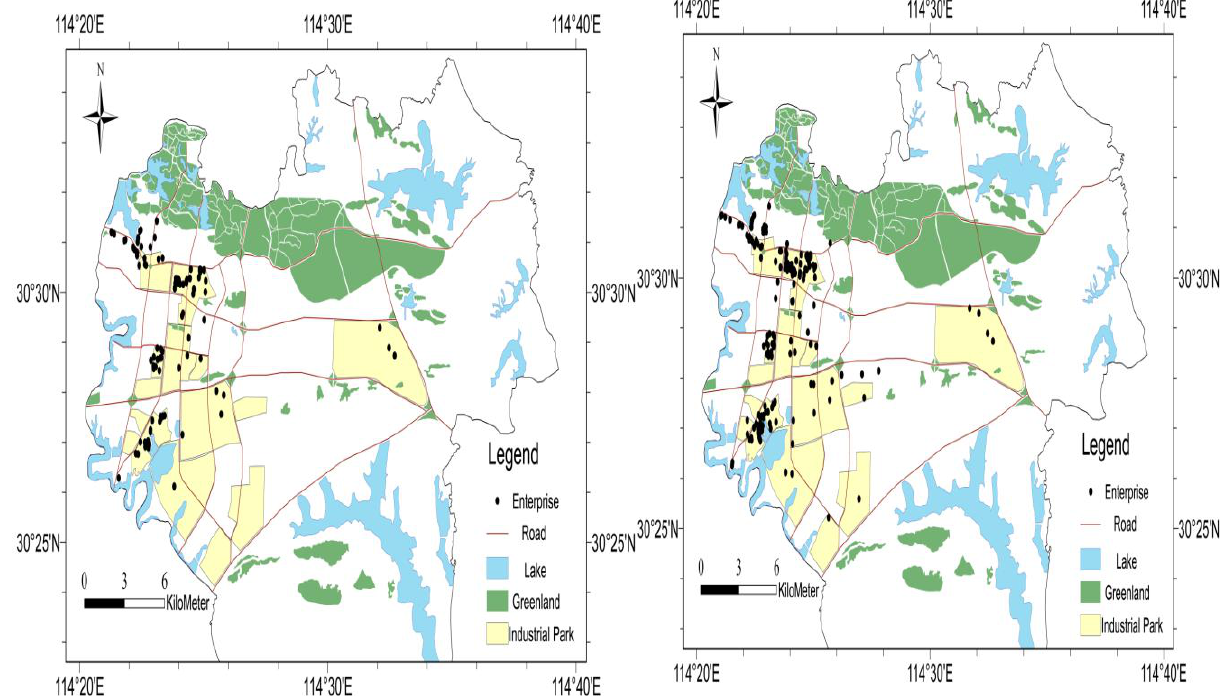
Fig. 4 Spatial distribution of enterprises in